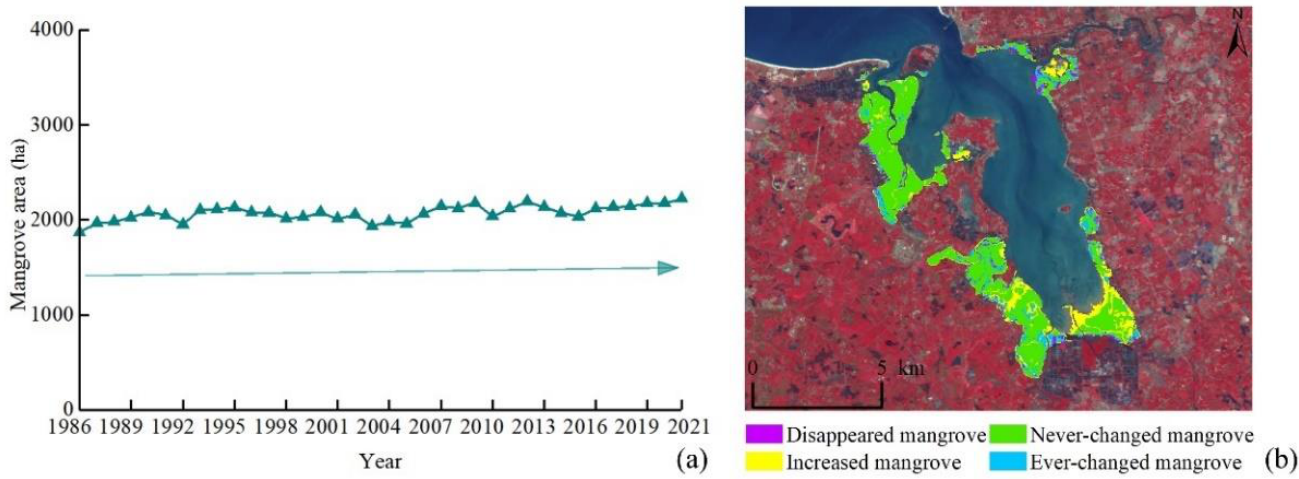
Figure 13. ( a ) Mangrove area and ( b ) changes to mangroves in DNNR during 1986 –